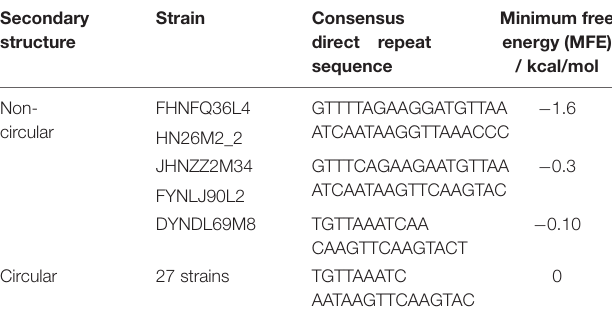
TABLE 2 | Classification for the DR